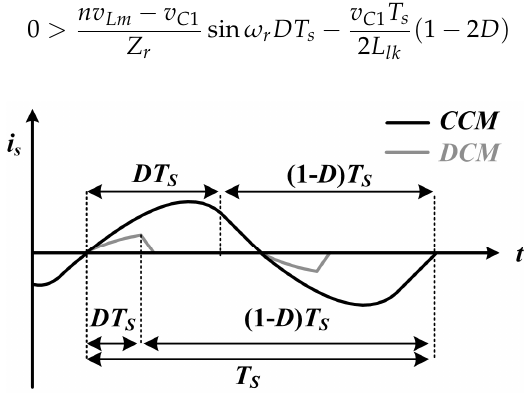
Figure 8. Secondary current i s of the transformer T 1 depending on the operating mode.